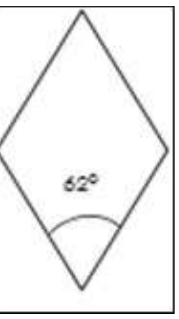
Fig. 1. Orthographic projection of a MDN